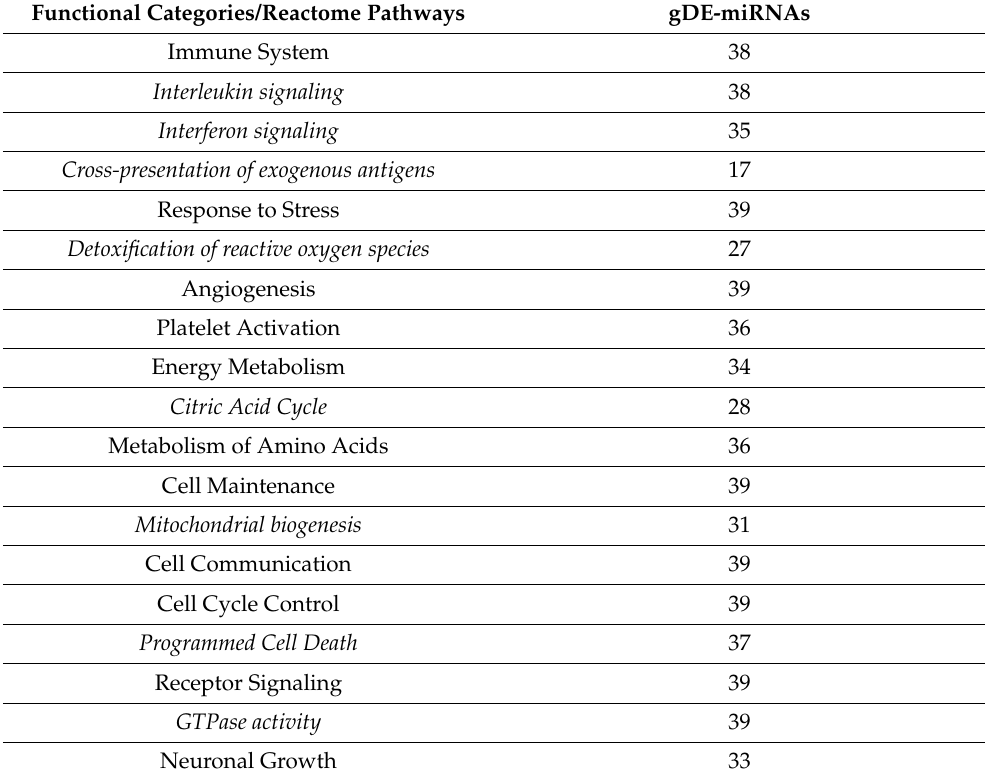
Table 11. Distribution of the 39 LS gDE-miRNAs targeting at least one gene in the enriched functional categories and selected reactome pathways. Pathways indicated in italics below the